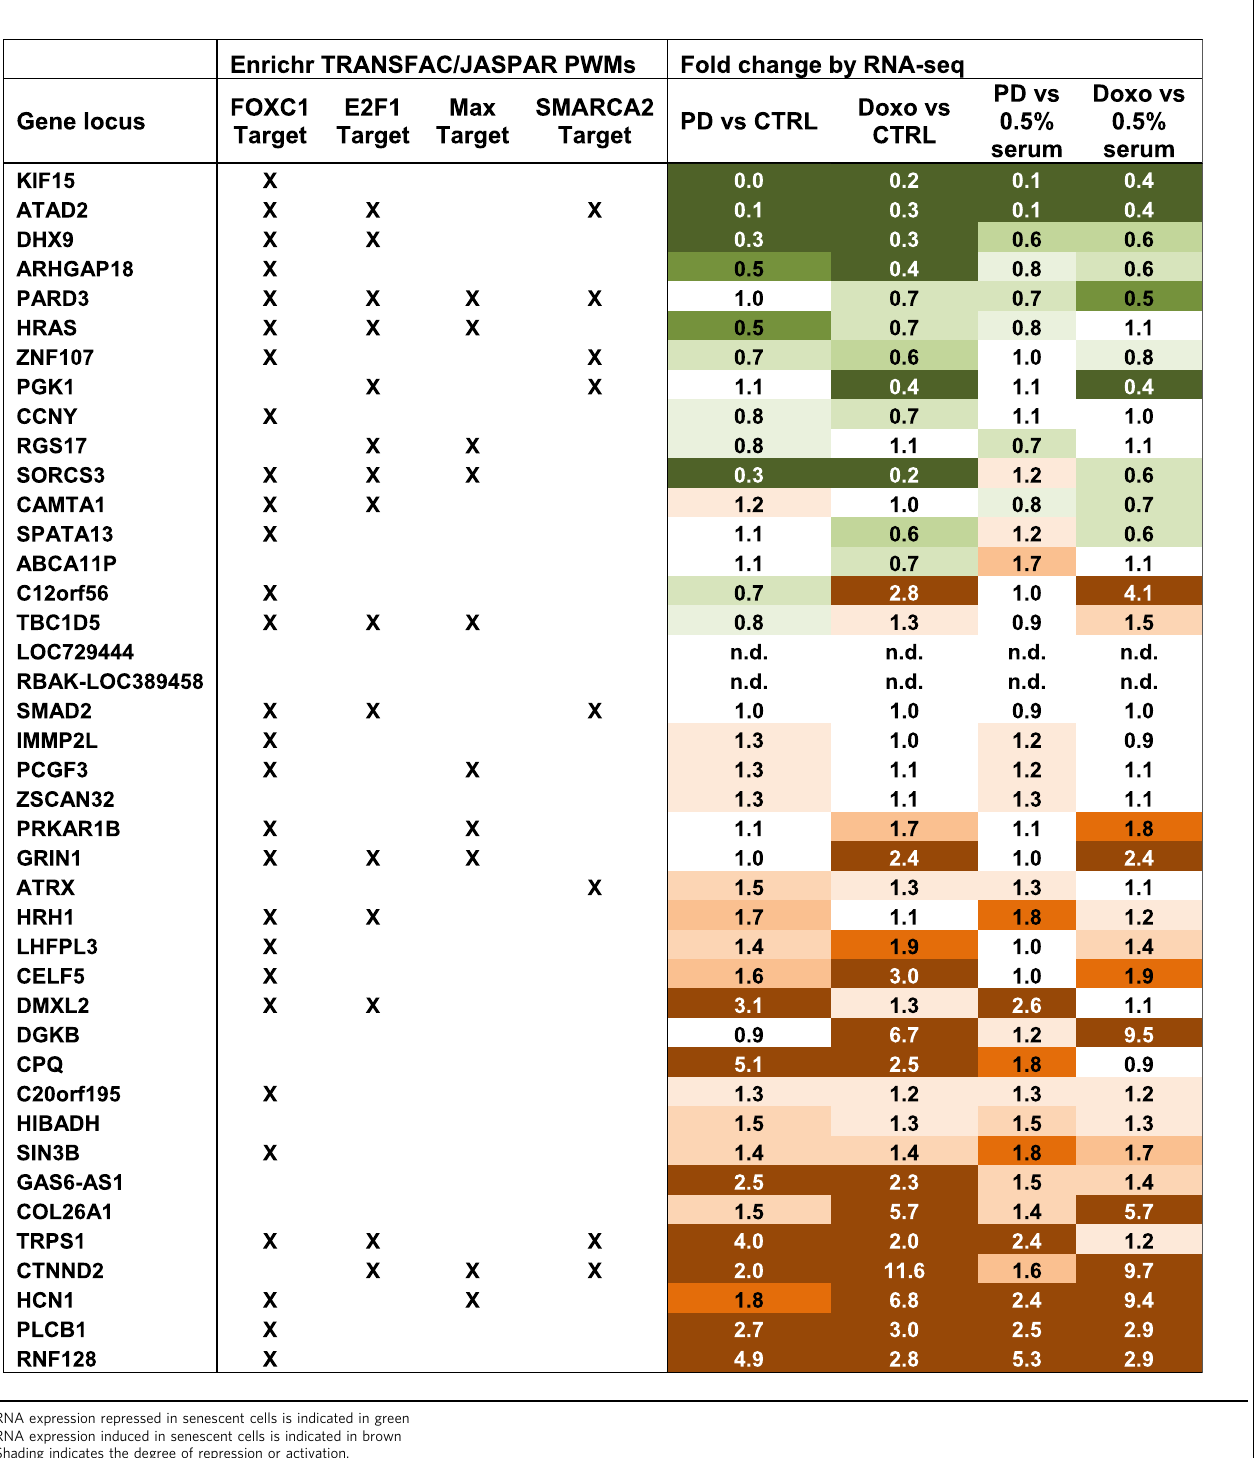
RNA expression repressed in senescent cells is indicated in green RNA expression induced in senescent cells is indicated in brown Shading indicates the degree of repression or activation. Fold repression/induction are indicated by the numbers n.d., not determined Ratios of gene expression in CDK4i-induced or doxorubicin-induced senescent cells compared to either cycling untreated cells or quiescent cells induced by serum starvation are shown. Whether each gene belongs to the TRANSFAC/JASPAR PWM transcription factor target gene sets as described in Fig. 6c is